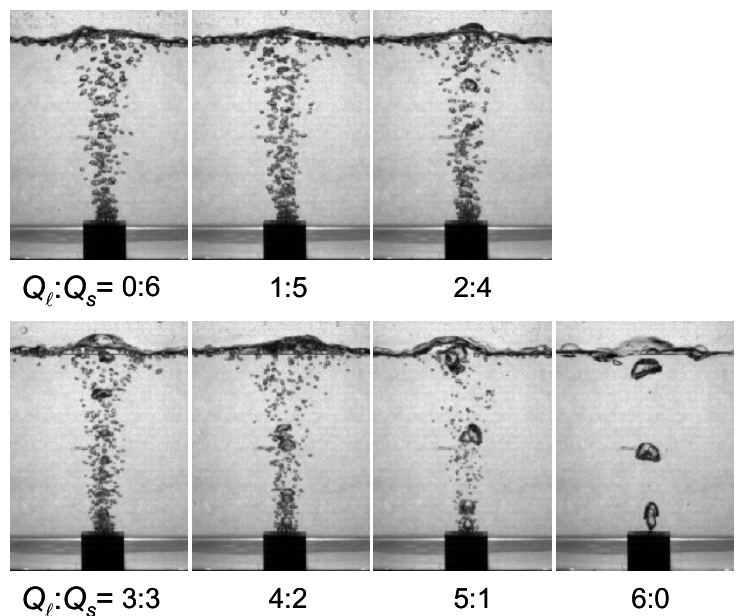
Fig. 3 Images of bubble